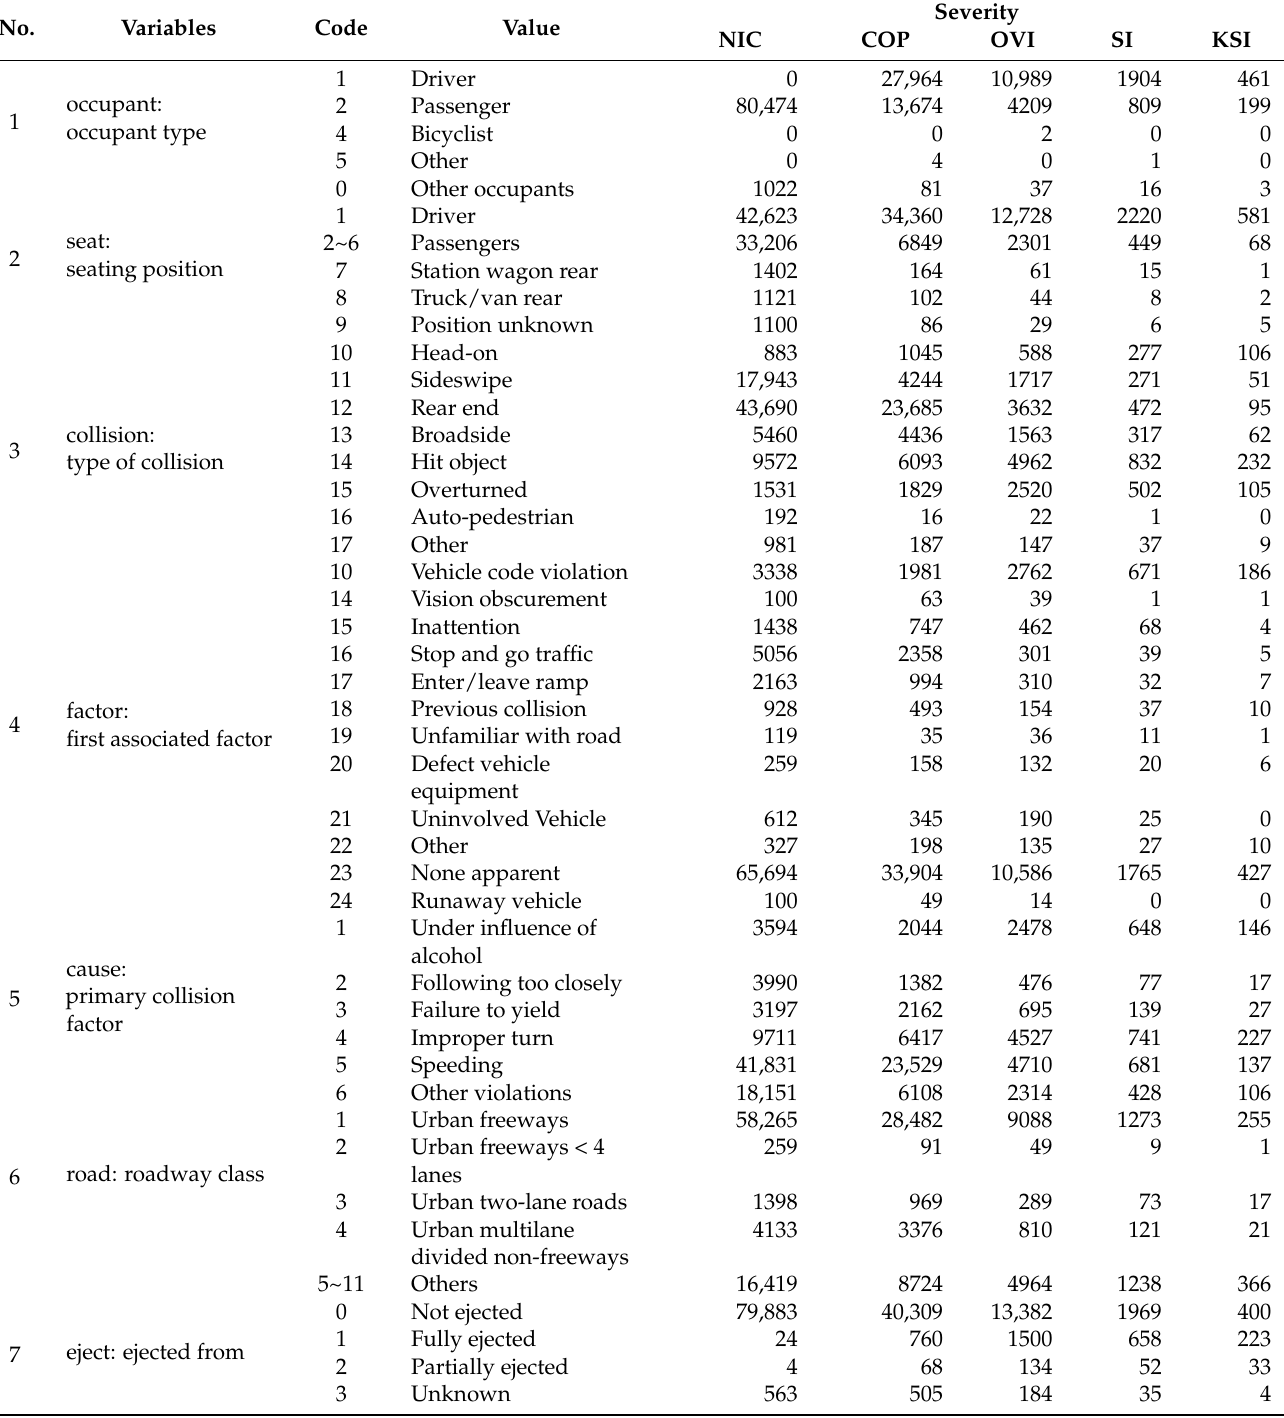
Table A1. Input variables and counts of different crash injury severity